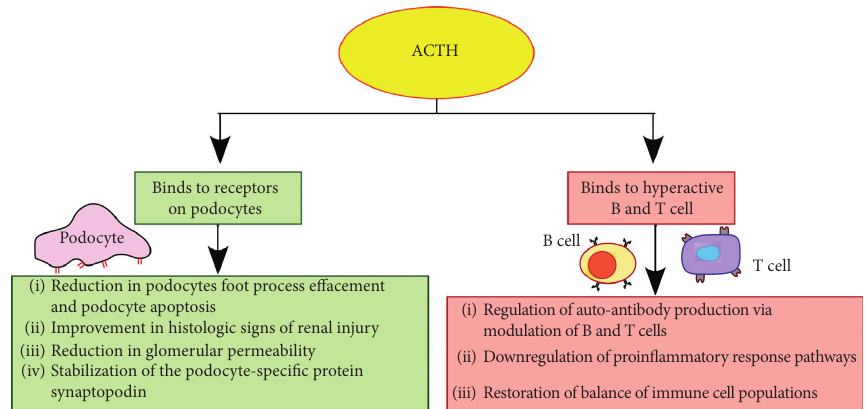
Figure 2: ACTH binding to receptors on the kidney and immune cells [9,